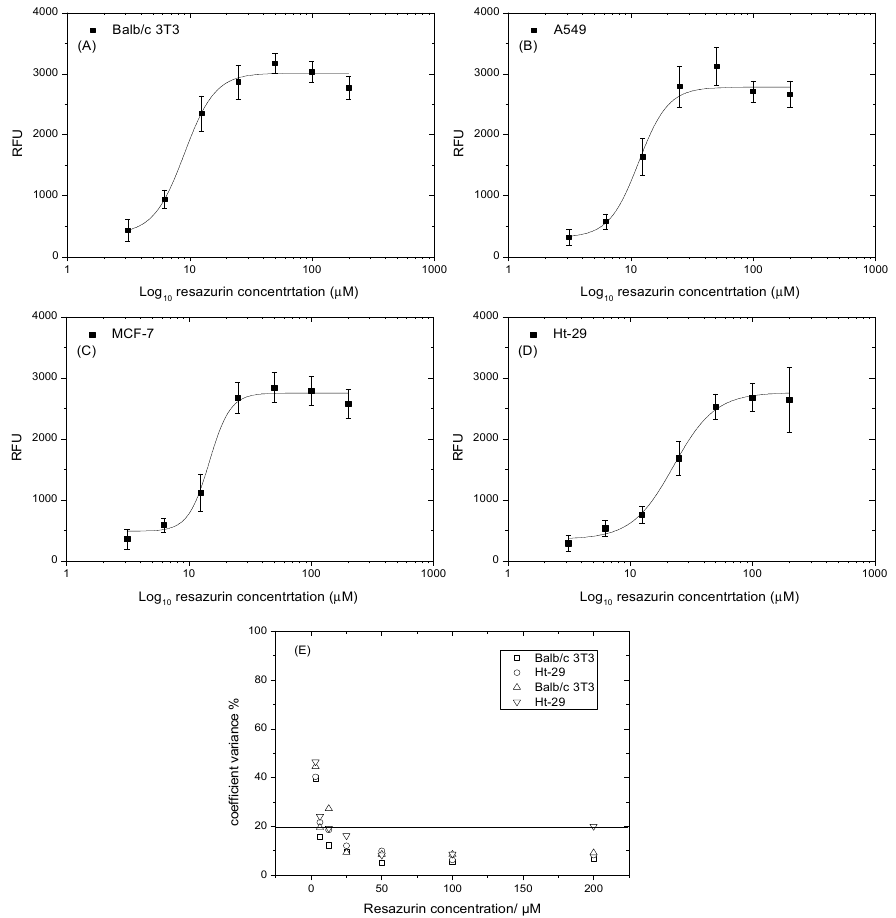
. SD of measurements of three ±